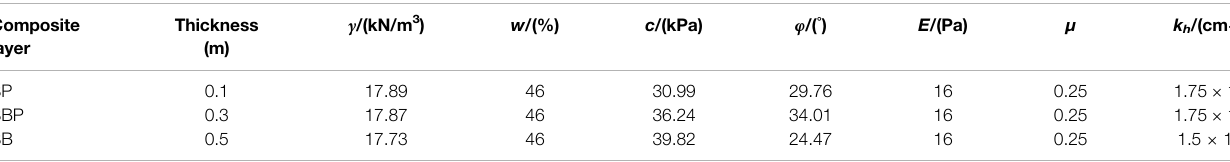
TABLE 9 | Mechanical parameters of SP, SBP and SB. Composite